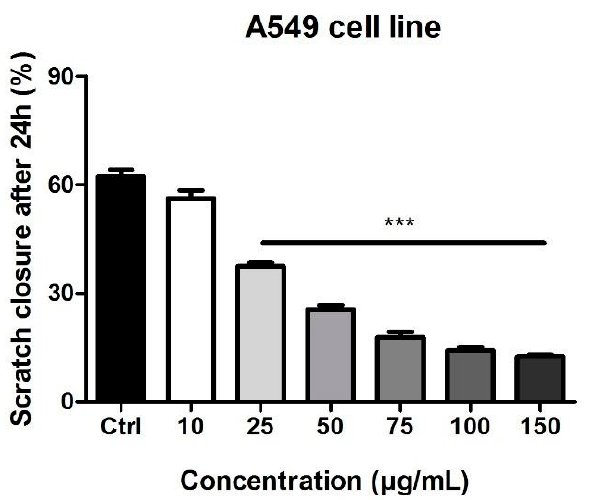
Figure 4. The anti-migratory potential of Pg extract (10, 25, 50, 75, 100, and 150 µg/mL) on A549 lung adenocarcinoma cells. The bar graphs are expressed as percentage of scratch closure after 24 h compared to the initial surface. One-way ANOVA test and Dunnett’s multiple comparison post-test were employed for comparison among groups (*** p < 0.001 vs. Control).